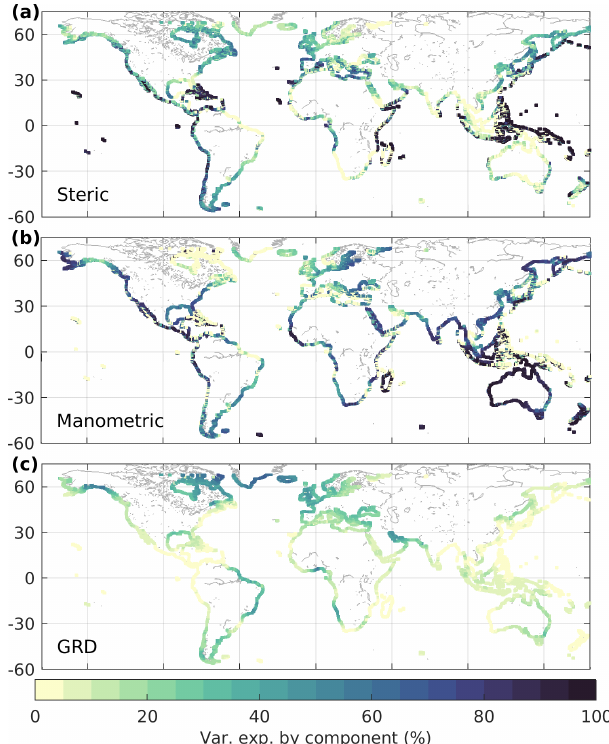
Figure 2. Proportion of variance explained (%) by sea-level com- ponents of the rolling decadal trends in sea surface height from the NEMO model by steric sea level (a) , manometric sea level (b) , and GRD, respectively (c) . Figure 1a presents the magnitude of the vari- ability (standard deviation).